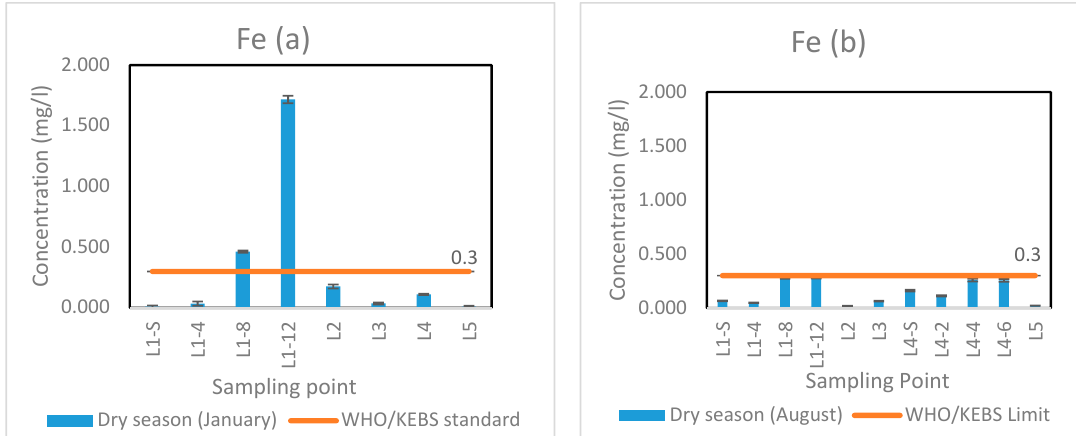
Figure 9. Iron concentration at various sampling points during the dry season: ( a ) January and ( b ) August.